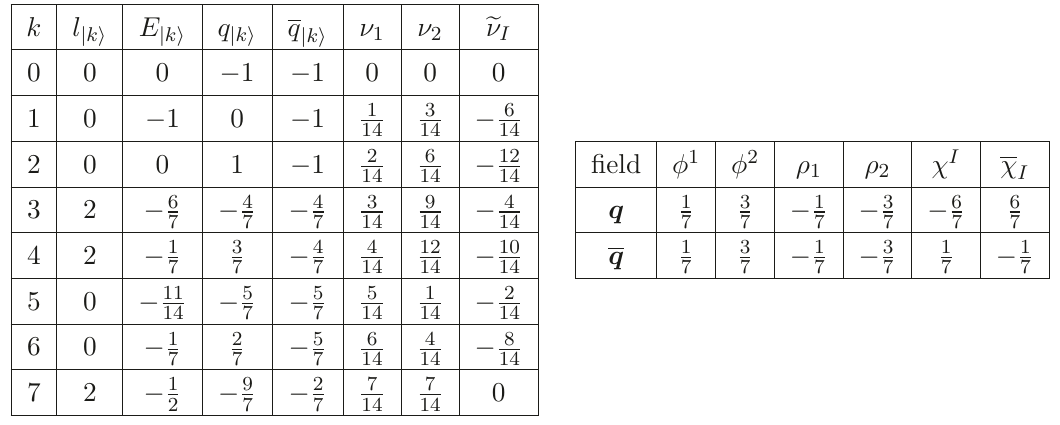
Table 5 . Quantum numbers for the E 7